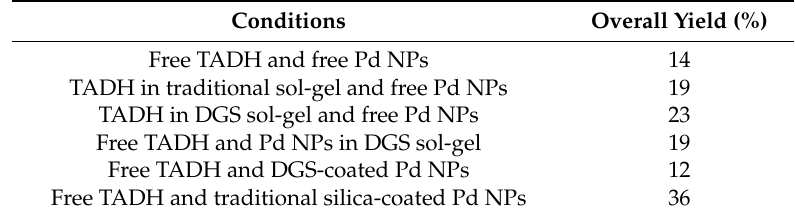
Table 2. 3-(1S,3S)-Methylcyclohexanol (from GC data) yields for the different methods used to perform one-flask reduction of